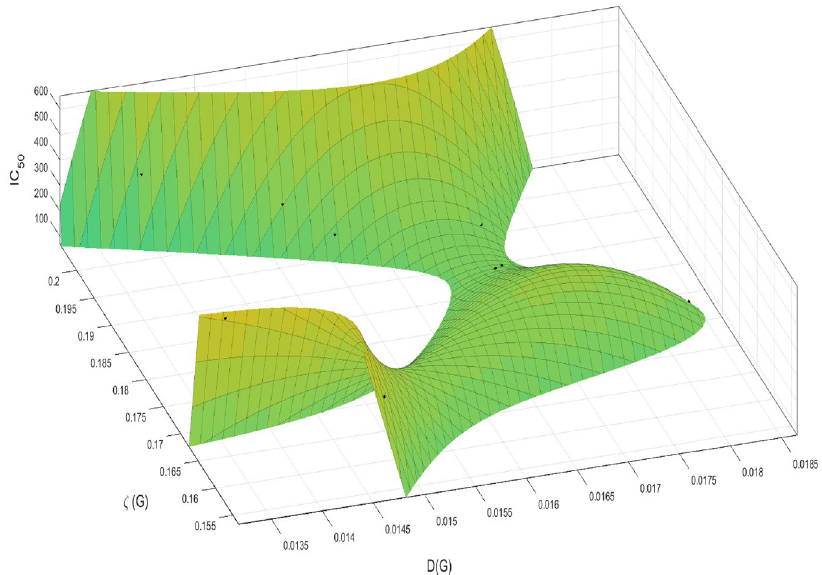
Figure 3. Show the multivariable polynomial fit to the